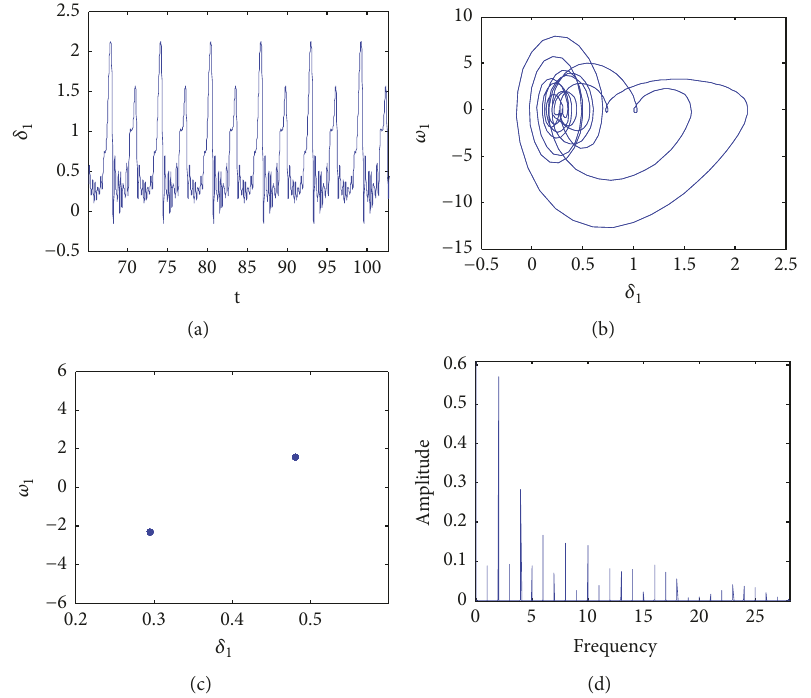
Figure 13: Period 2 motion ( D =0.009). (a) Time history. (b) Phase portrait. (c) Poincar´e map. (d) Frequency